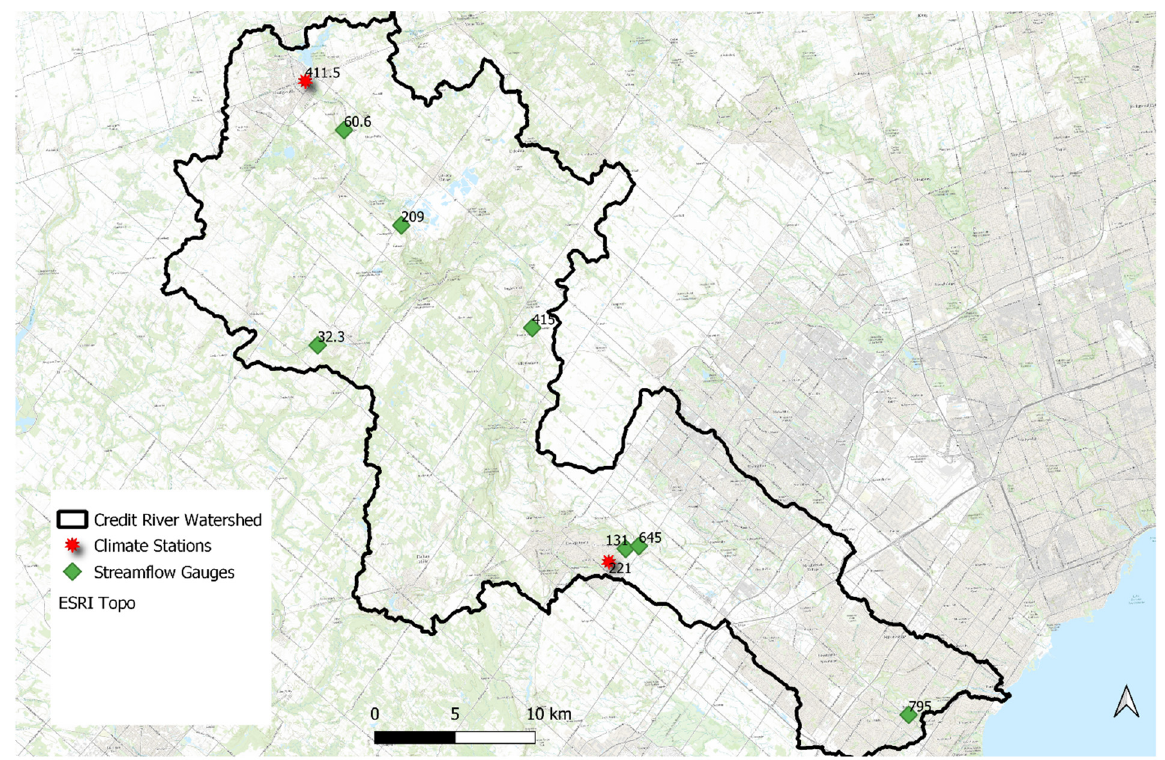
Figure 1. Credit River watershed with the locations of the streamflow and climate stations. The number indicates the drainage area (km 2 ) and elevation (m).